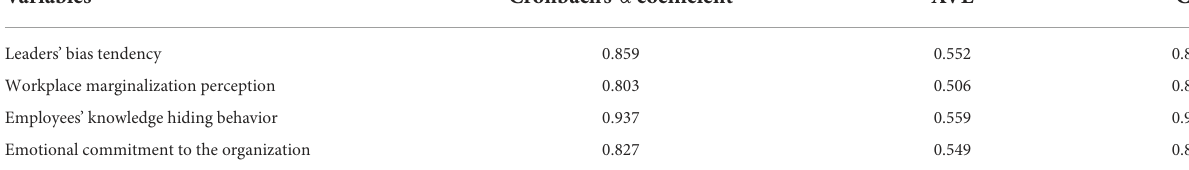
TABLE 1 Reliability analysis.